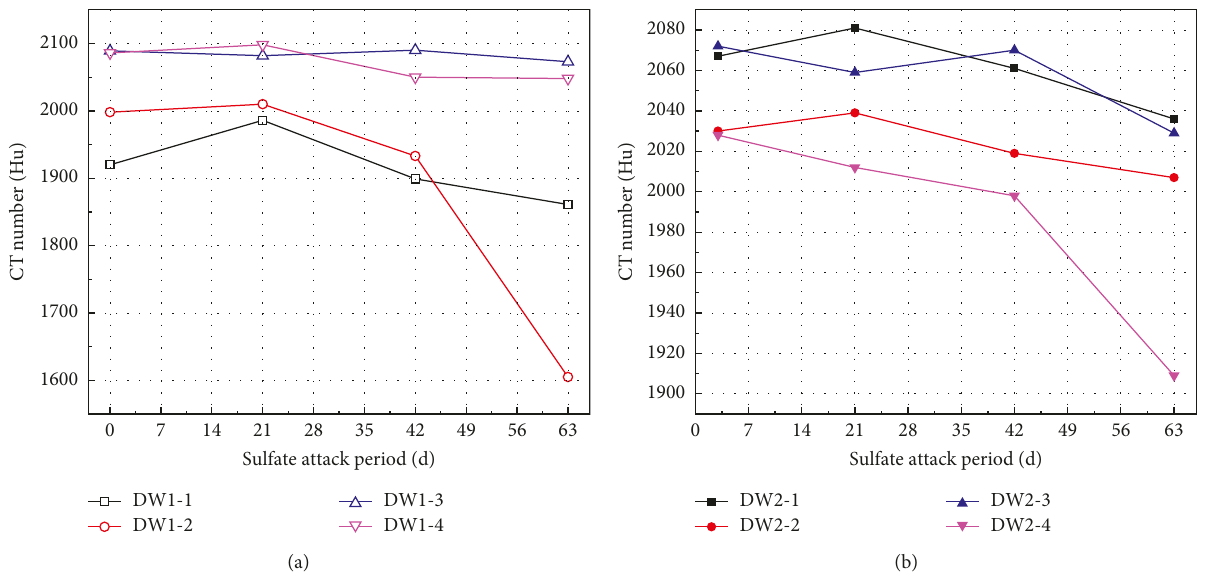
Figure 15: Variation of the average CT numbers of DW-1 and DW-2 exposed to drying-wetting cycles with sulfate attack.